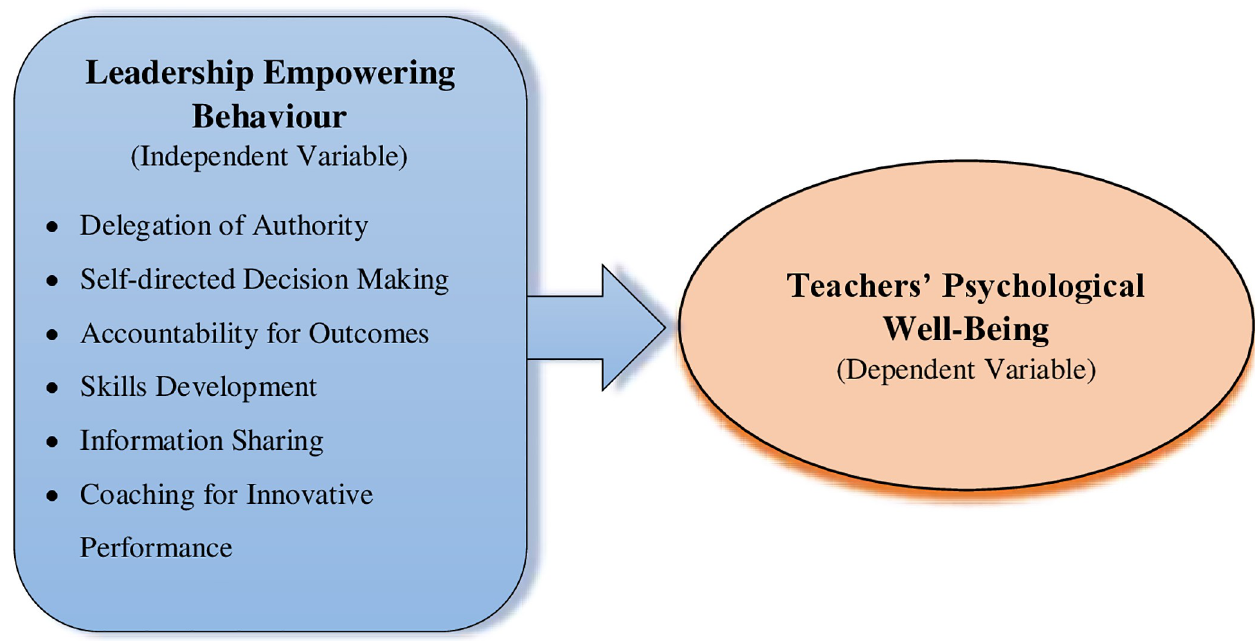
Fig 1. Conceptual framework. Indicating the Multiple Linear Regression Model between leadership empowering behaviour (independent variable) and teachers’ psychological well-being (dependent variable).